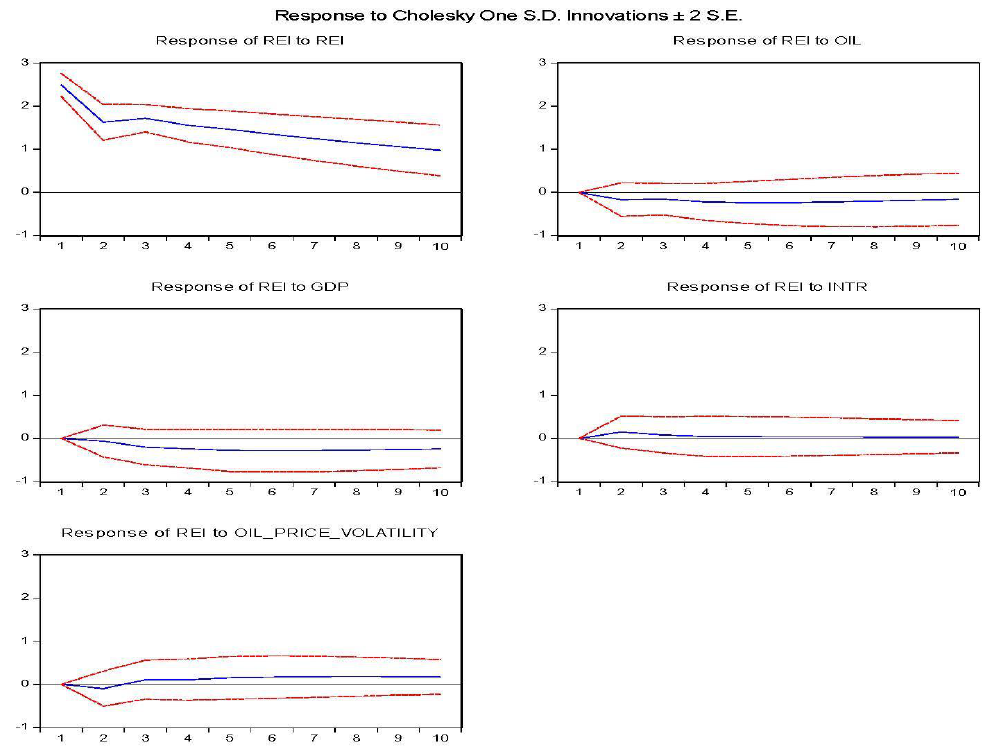
Figure 1. Results of the dynamic response of Renewable Energy Investment (REI), oil price, Gross Gross Domestic Product growth (GDPg), interest rate and oil price volatility over 28